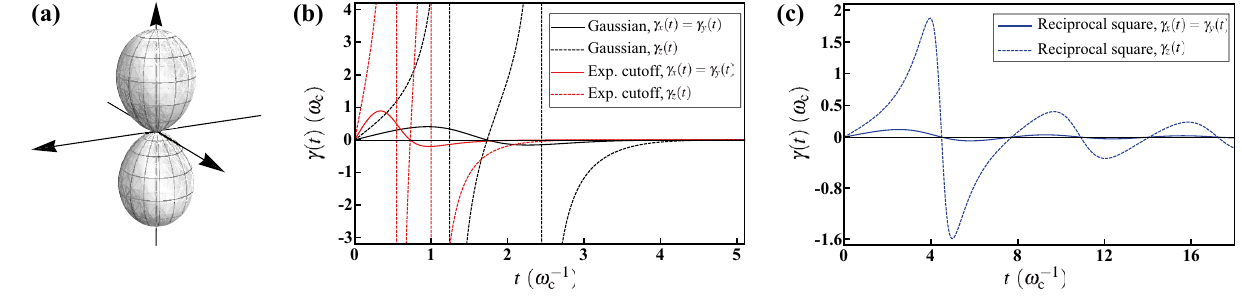
Figure 4. Decoherence under the HE with dumbbell-shaped geometry. ( a ) Visualization of the solid ( 3 / 4 π) cos 2 θ of the probability distribution. The dumbbell-shaped geometry angular part �(θ , φ) = exhibits the azimuthal and reflectional symmetries simultaneously; meanwhile, this leads to the regime < 1 / 3 < γ x ( t ) (solid curves) and γ z ( t ) (dashed curves) for the n 2 n 2 n 2 z � � . ( b ) The decay rates y � � x � � = � � � Gaussian (black) and the exponential cutoff (red) radial functions. γ x ( t ) ’s are finite with smaller amplitudes, whereas γ z ( t ) ’s are singular. Furthermore, γ x ( t ) for the exponential cutoff approaches zero asymptotically from above after a mild rising. ( c ) The decay rates γ x ( t ) (solid curves) and γ z ( t ) (dashed curves) for the reciprocal square radial function. Both of the decay rates exhibits the same temporal behavior. Finally, in these plots, we can see the analogy between the amplitudes of γ j ( t ) ’s and the relationship